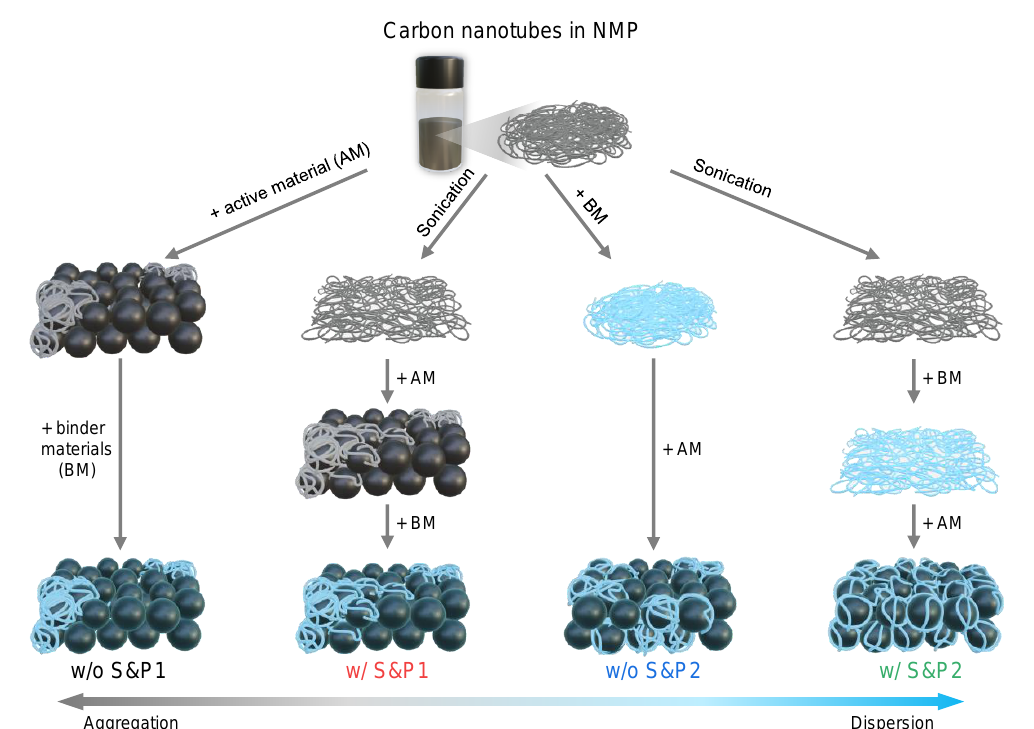
Figure 1. Scheme of preparation routes for the four types of electrode made by varying two conditions: (i) the mixing order of the conductive material, binder and active material and (ii) the sonication process of the CNTs/NMP solution before the electrode slurry preparation. Electrodes were manufactured individually with the four slurries. The morphology and coverages of CNTs adsorbed to the cathode materials in the electrodes were analyzed using scanning electron microscopy (SEM). Figure 2 shows the SEM images in BSE mode, presenting the top view of the electrodes prepared via the four methods with 60 wt% of solid content in the slurry. The SEM images in BSE mode show higher atomic number materials as brighter, while the lower atomic number materials appear as darker [28,29].